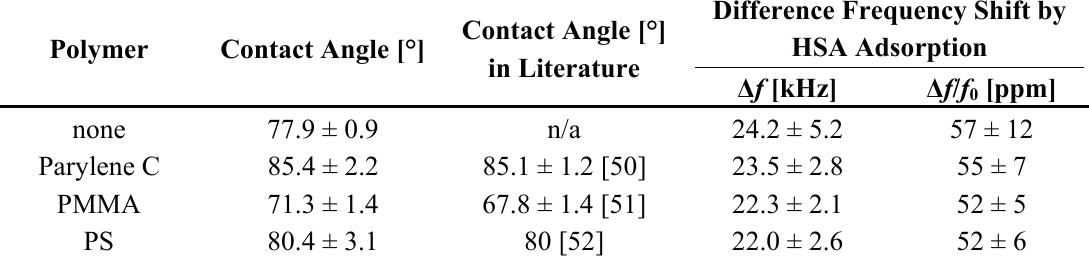
Table 3. Polymer coated SAW resonators ( f 0 = 426.4 MHz): Contact angle with water and difference frequency shifts Δ f obtained by HSA adsorption ( n = 4). Samples